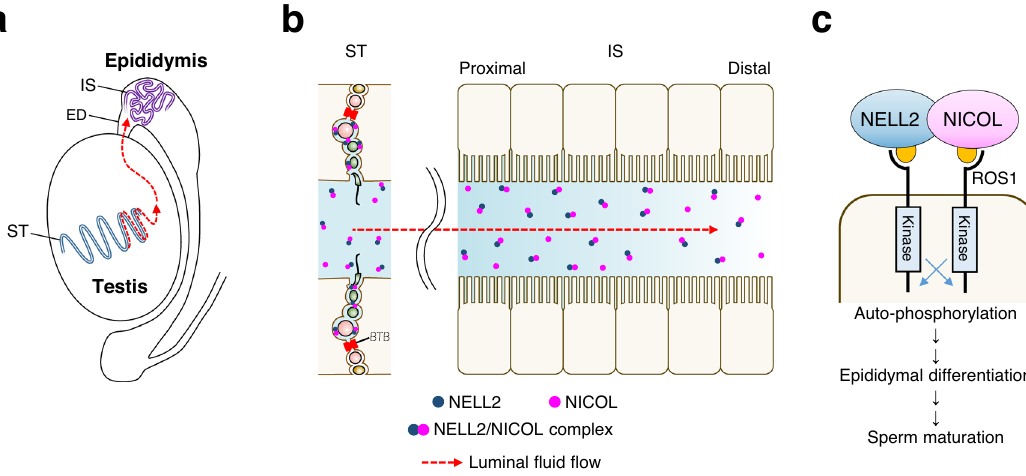
Fig. 7 | Possible working model of NICOL in lumicrine signalling. a The luminal fl uid inside testicular seminiferous tubules fl ows and reaches epididymal IS via efferent duct. b The NELL2and NICOLproteins secretedinto seminiferous luminal fl uid form a complex and reach the epididymal IS by the luminal fl ow. Spermato- cytesseemstoplayacriticalroleinlumicrinefactorsecretionastheyexpressboth Nell2 and Nicol at the highest level in testicular cells. A contribution to the luminal